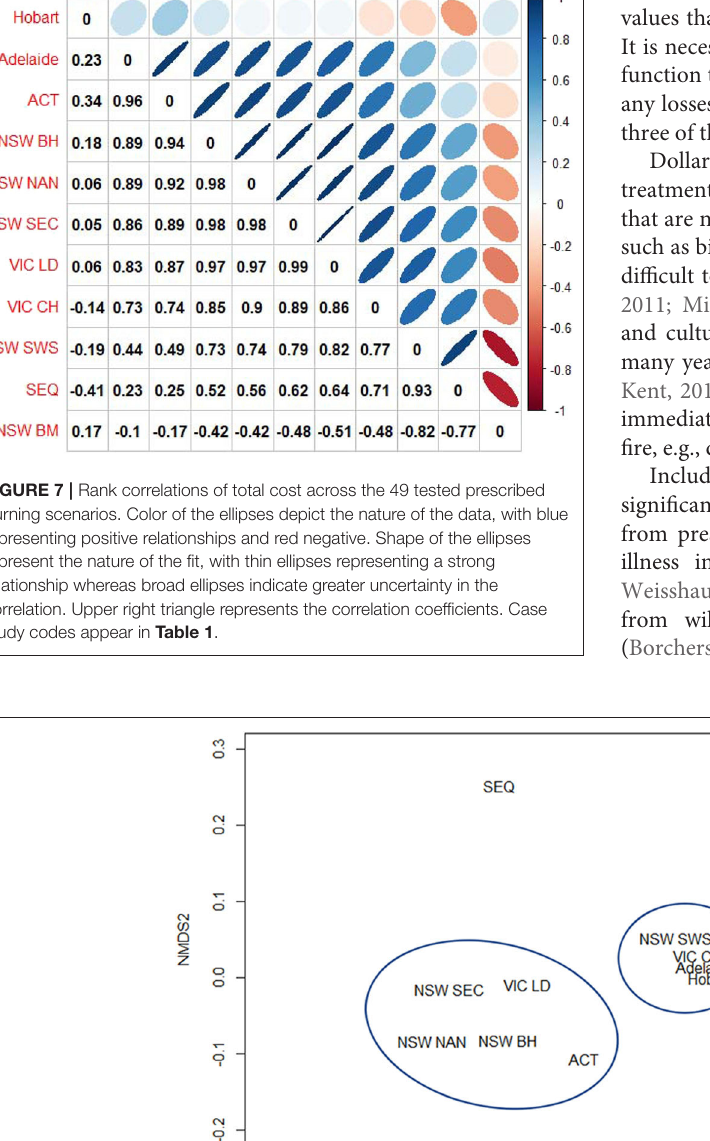
Frontiers in Forests and Global Change |